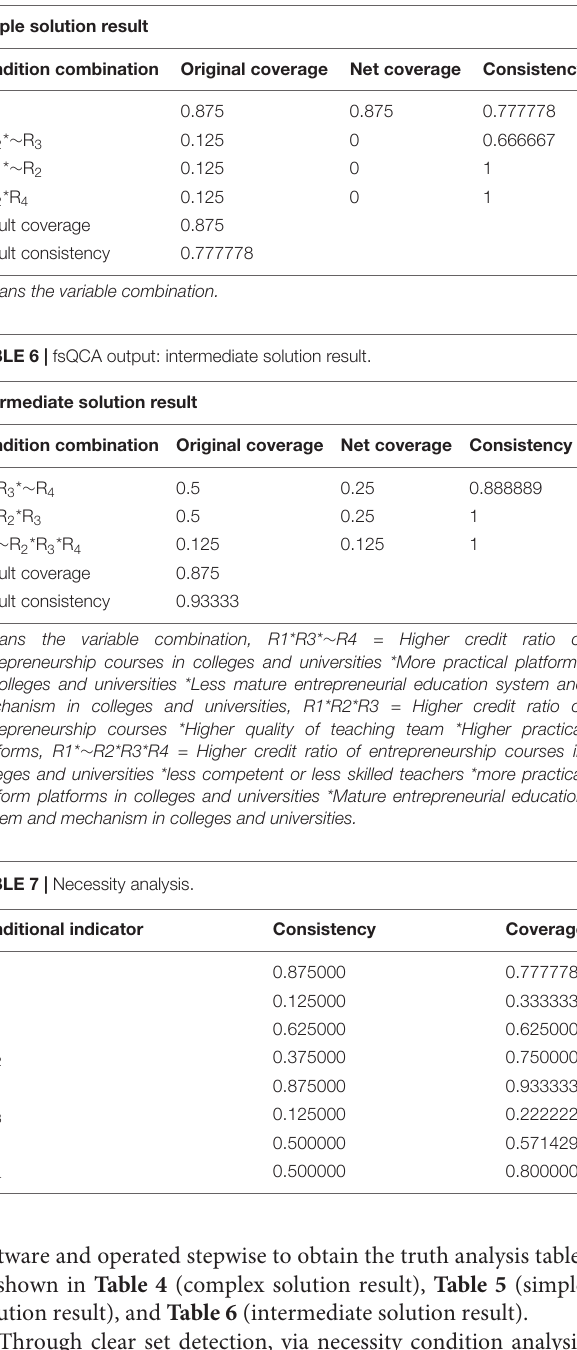
TABLE 5 | fsQCA output: simple solution result.